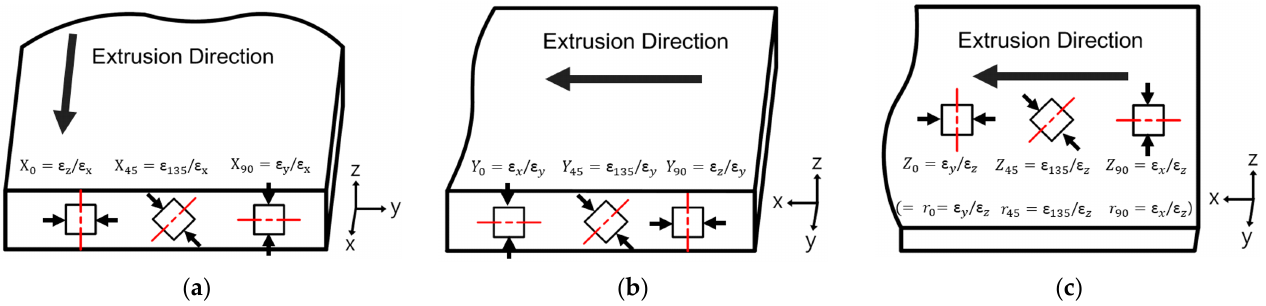
Figure 3. Loading directions for small-cube compression test: ( a ) Specimen on X-plane, ( b ) Specimen on Y-plane, ( c ) Spec- imen on Z-plane.